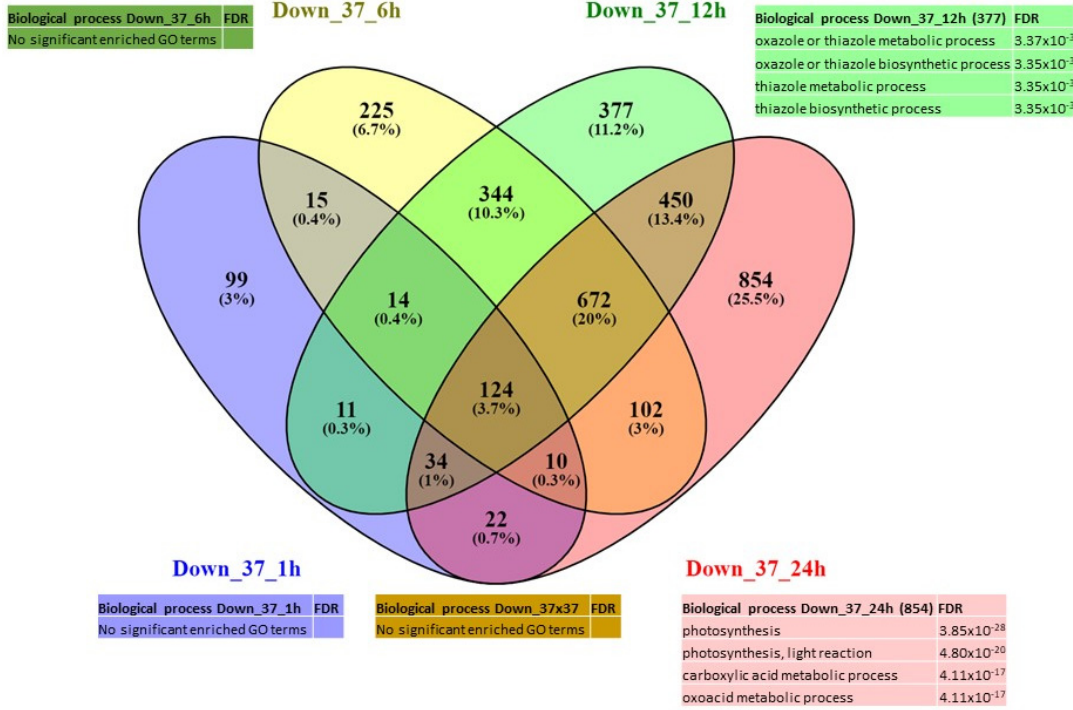
Figure 6. Venn diagram of expression data analysis at 37 °C of the down-regulated genes at 1, 6, 12 and 24 h; and associated GO terms. Down_37_1h = down-regulated DEG at 37 °C at 1 h, Down_37_6h = down-regulated DEG at 37 °C at 6 h, Down_37_12h = down-regulated DEG at 37 °C at 12 h, Down_37_24h = down-regulated DEG at 37 °C at 24 h.